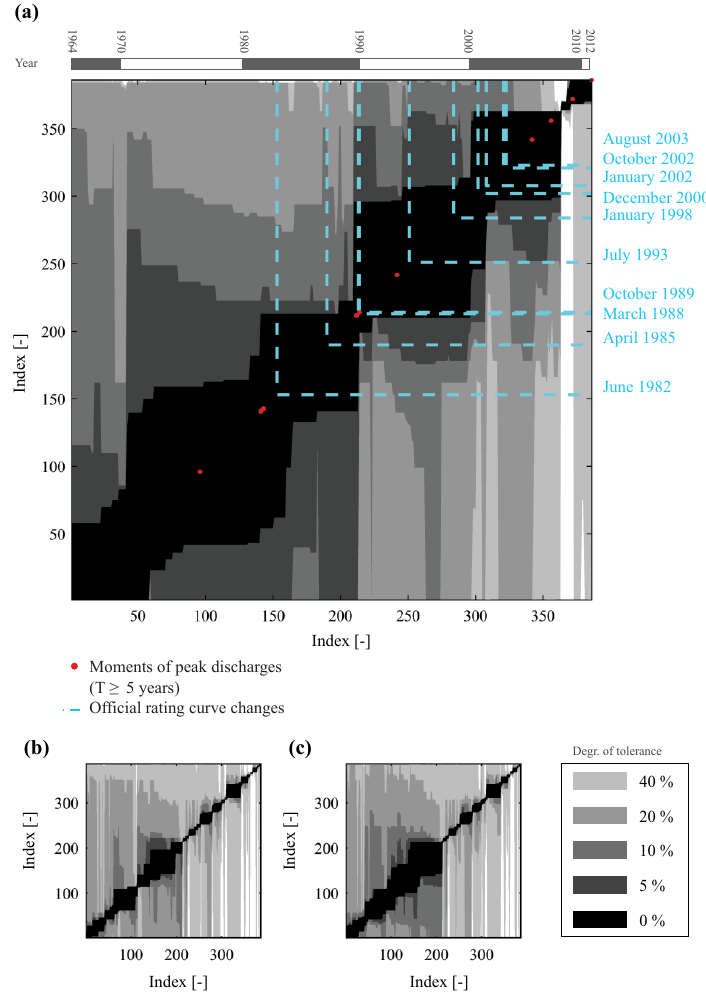
Figure 4. Combined (a) BReach t_3s plot (winter data), (b) BReach t_1s plot (winter data) and (c) BReach t_2s plot (winter data) for Clog-y- Fran. In all subplots, for each index on the x axis the gray area indicates the span between the index of the maximum left reach (under the bisector) and the maximum right reach (above the bisector). Each gray tint represents a different degree of tolerance (i.e., percentage of data points allowed to have nonacceptable model